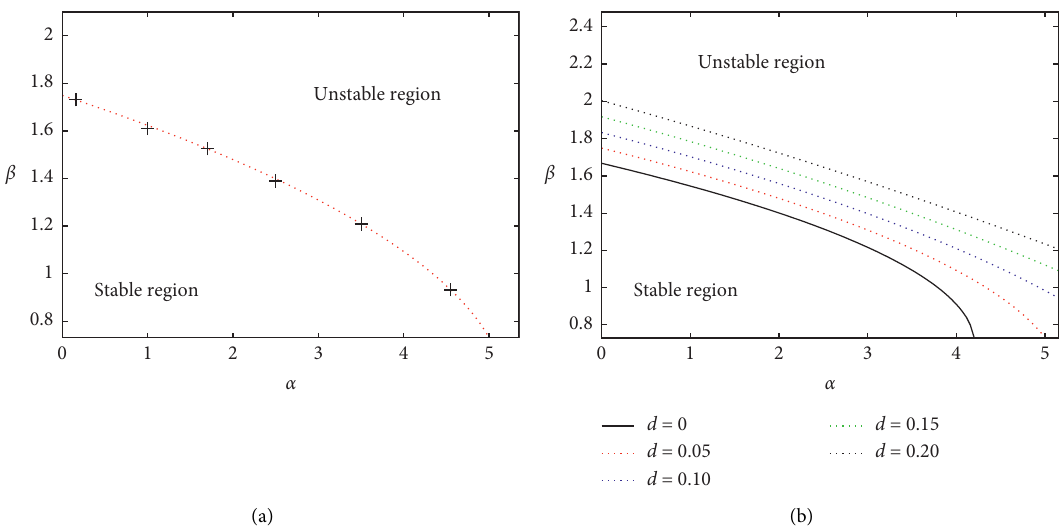
Figure 5: The Hopf bifurcation maps on the α − β diagrams: (a) an exploration of the analytical and numerical simulation results and (b) plots of the analytical ODE results for five different values of the diffusion coefficient d